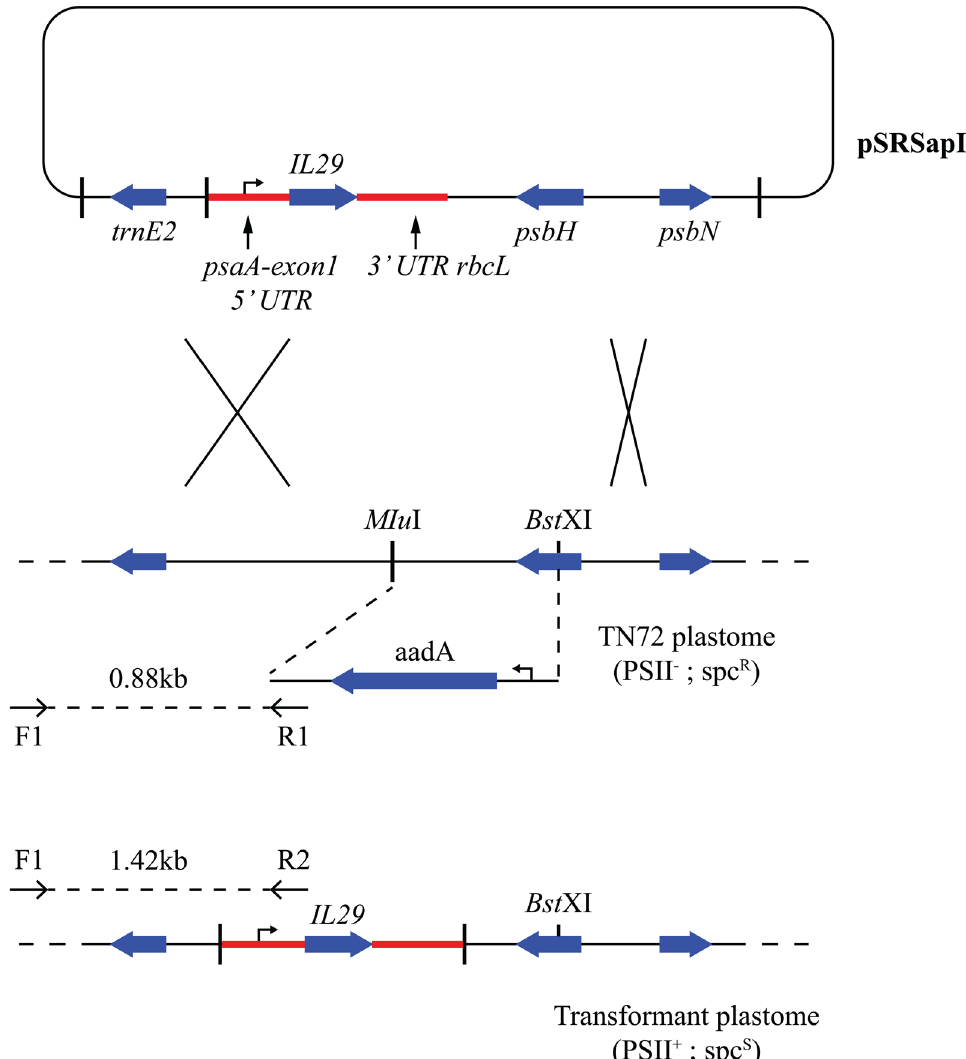
Fig. 2 Mechanism of homoplasmy; Integration of IL29 and loss of aadA cassette in plastome of TN72 occurs by two homologous